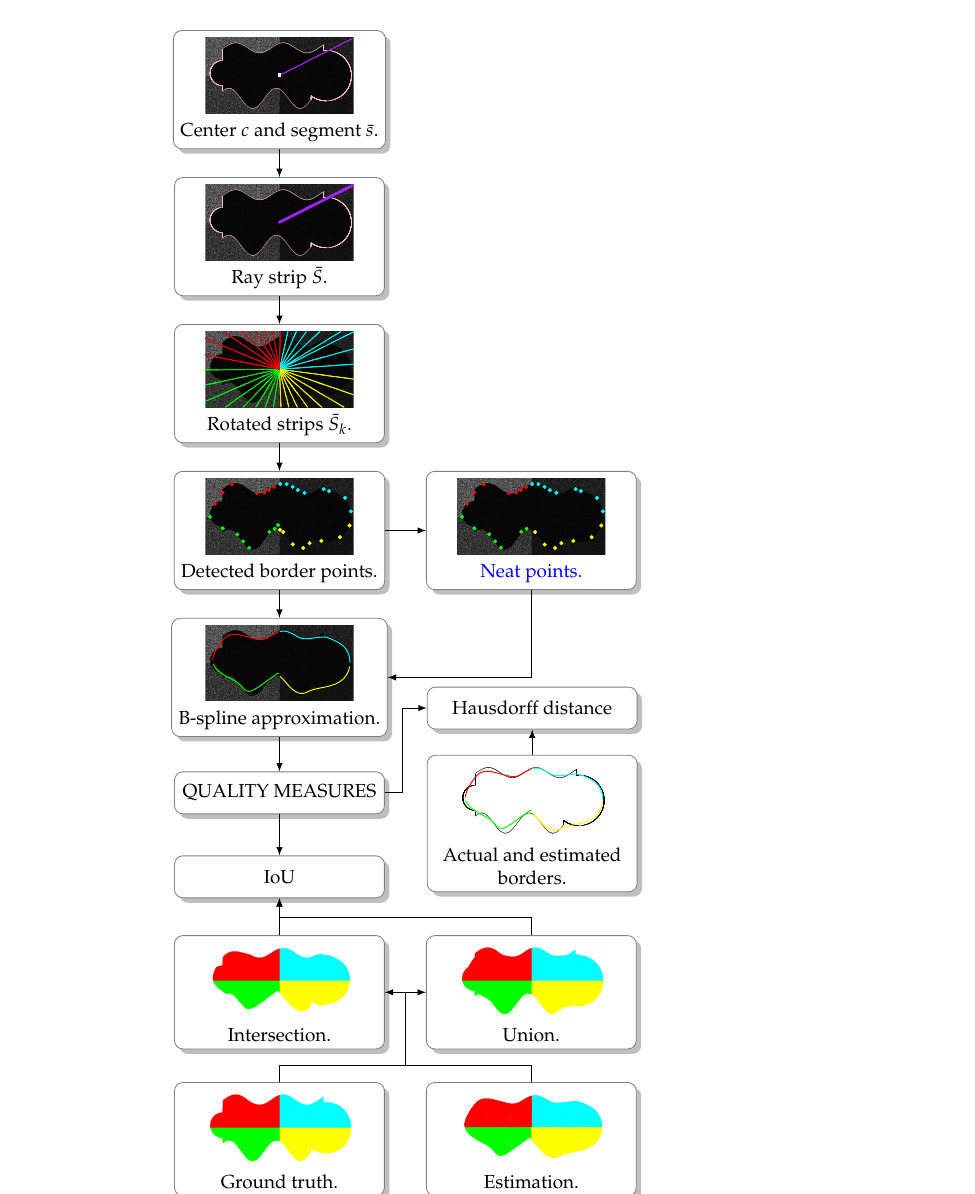
Figure 5. Complete workflow to find the target’s border, together with quality